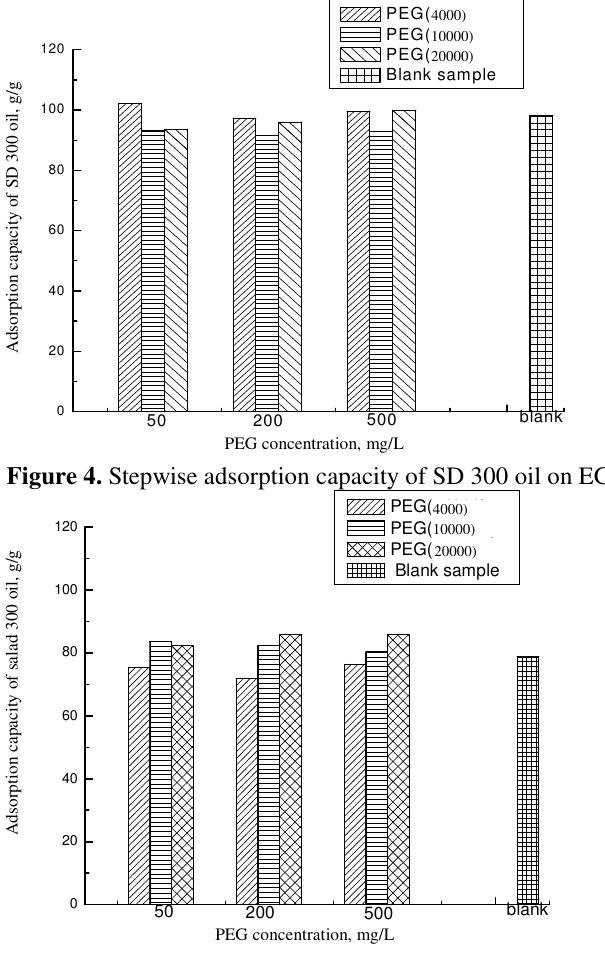
Figure 5. Stepwise adsorption capacity of salad oil on